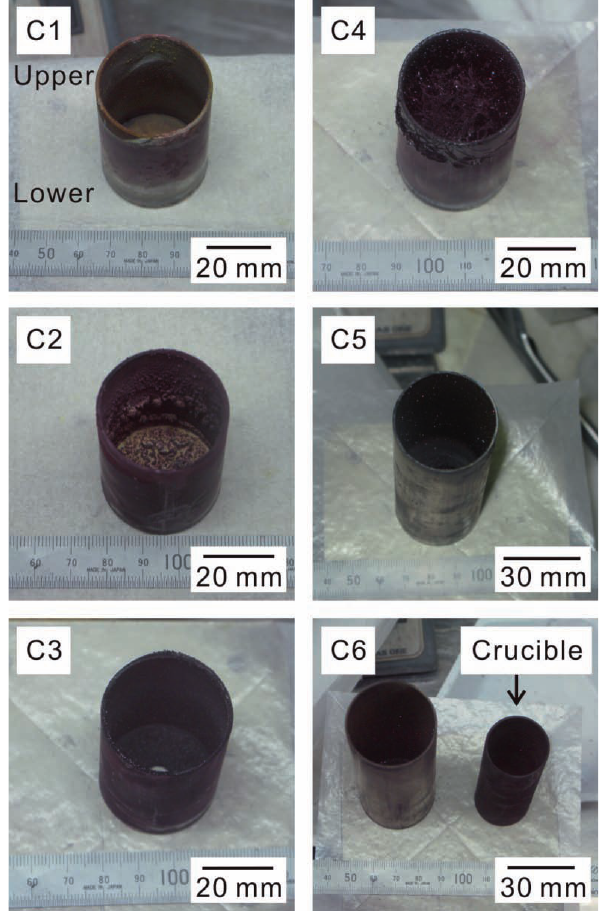
Figure 4. Photographs of the collectors after the distillation